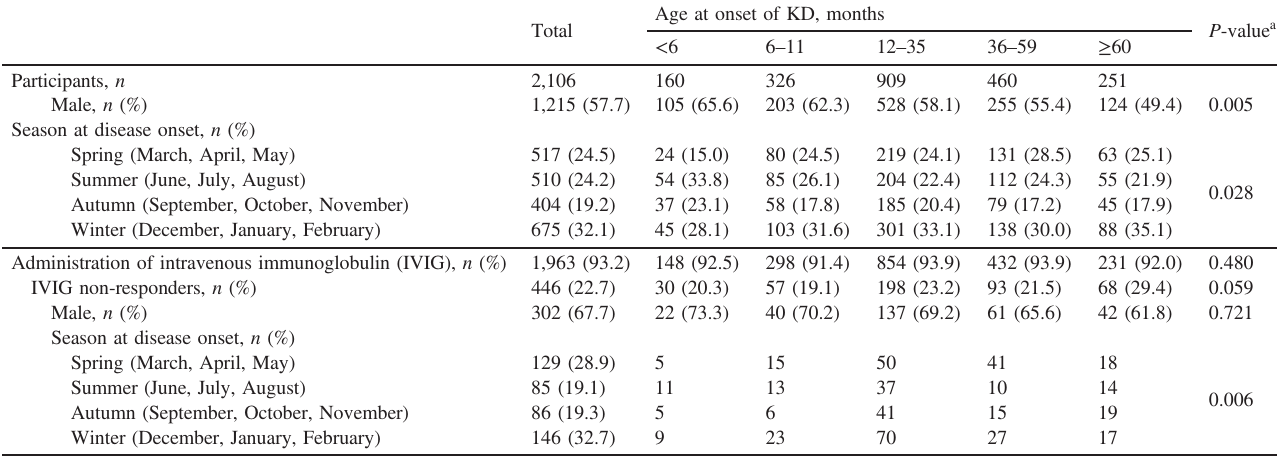
Table 1. Characteristics of study participants strati fi ed by age at onset of Kawasaki disease (KD) ( n = 2,106)